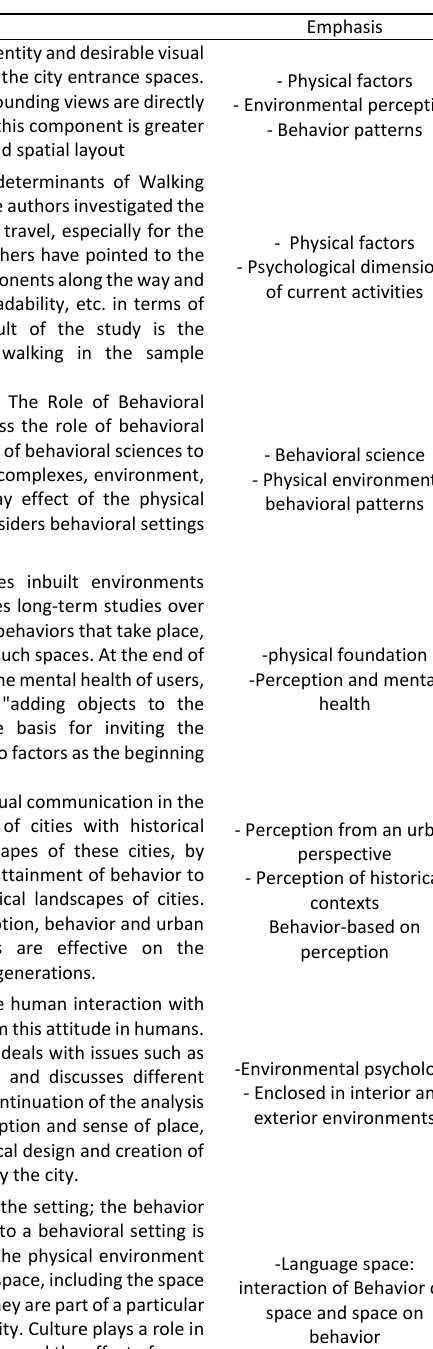
Table 1: Selected literature in the field of perception and behavior